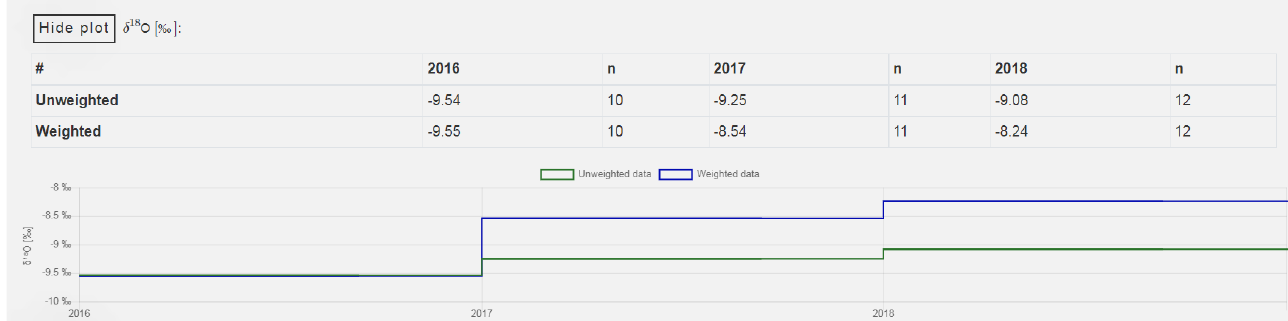
Figure 5. The snapshot of the numerical and graphical presentation of δ 18 O annual unweighted and weighted means at the Murska Sobota station [52].